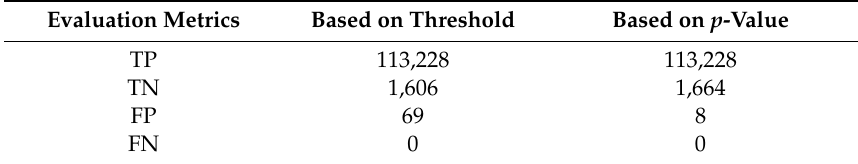
Table 5. Comparison of confusion matrix based on Support Vector Machine (SVM) results.